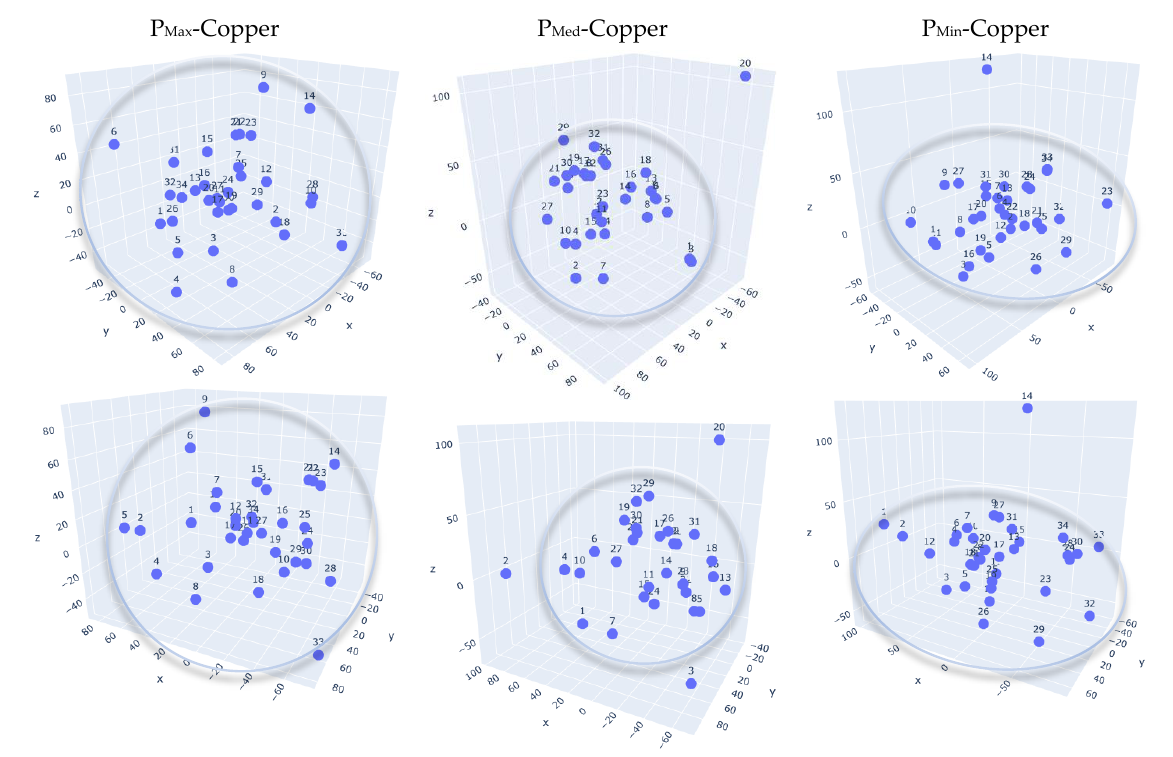
Figure A1. A series of differing perspectives for the PCA analysis of Figure 5b.